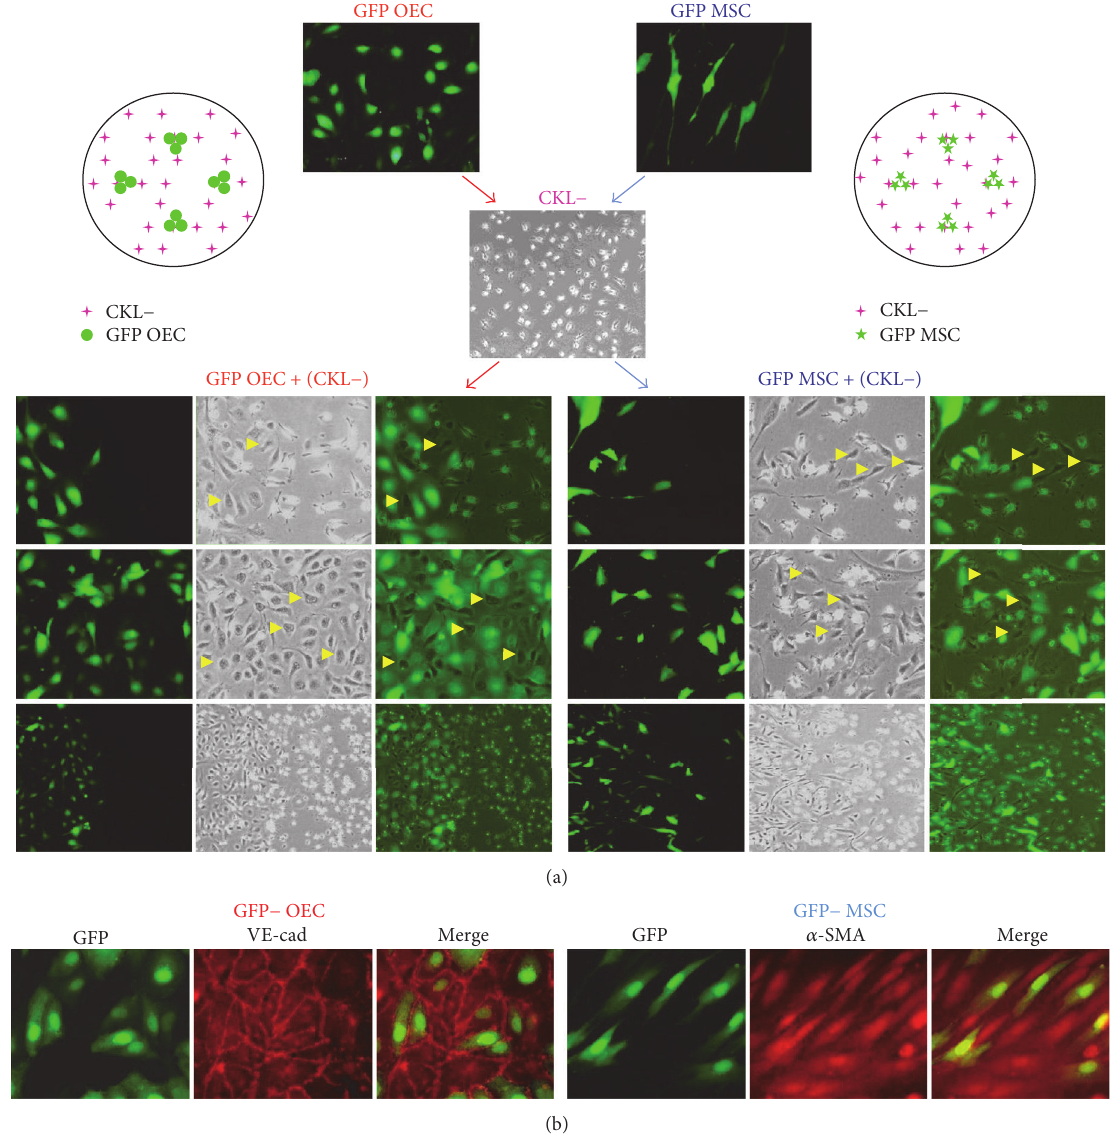
Figure 2: The microenvironment induces the differentiation of CKL − cells into OECs or MSCs. (a) CKL − cells were cocultured with GFP − transfected OECs or MSCs. After 3 days in culture, GFP − OECs or MSCs began to appear among GFP + OECs or MSCs cells, respectively (arrowheads). (b) GFP − OECs and MSCs differentiated from CKL − cells were confirmed by immunofluorescent staining for VE-cad and 𝛼 -SMA antibody,